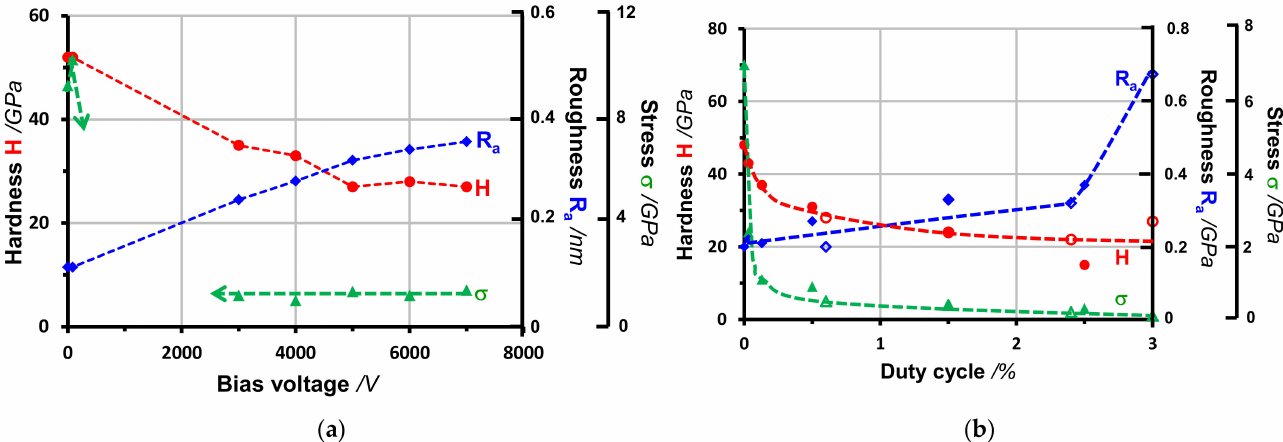
Figure 17. Hardness, compressive stress and roughness of carbon films, prepared by filtered vacuum arc deposition. ( a ) Dependence on the bias voltage (dc bias of 0 V and 85 V, pulsed bias of 3–7 kV with 25 µ s, 600 Hz). Data from [77]. ( b ) Dependence on the duty cycle of 5 kV bias pulses. (Solid symbols: variation of the frequency of 25 µ s pulses, empty symbols: variation of the pulse length at 600 Hz). Data from